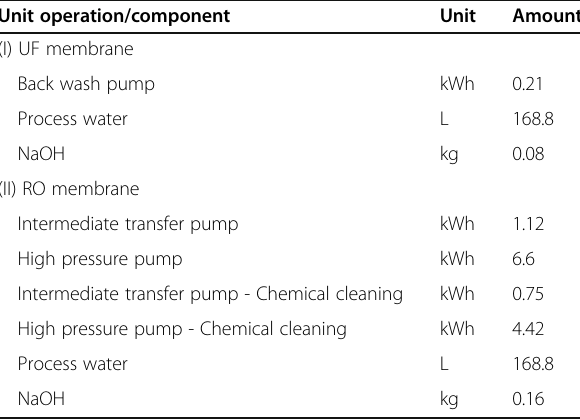
Table 4 Life cycle inventory of Combination IV for integrated membrane-filtration